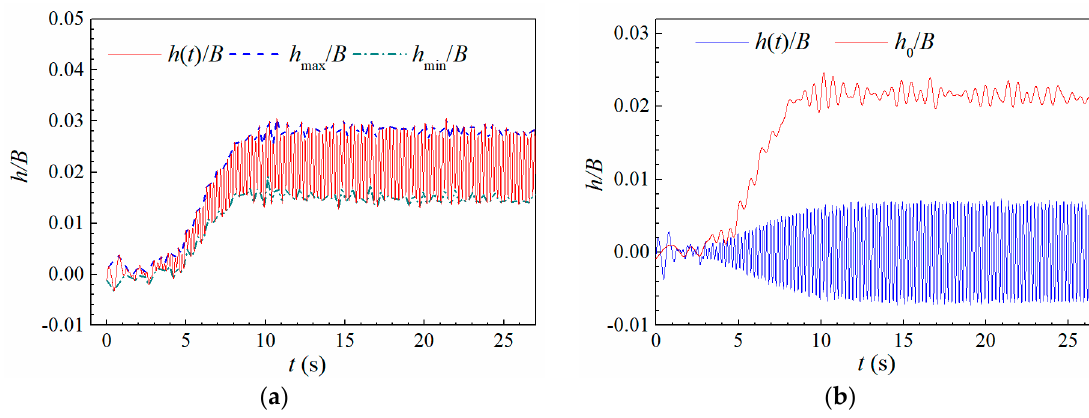
Figure 8. Separation of post-critical LCO and static deformation (Case A1, U * = 5.365) ( a ) Recorded heaving displacement; ( b ) pure heaving vibration and static displacement.